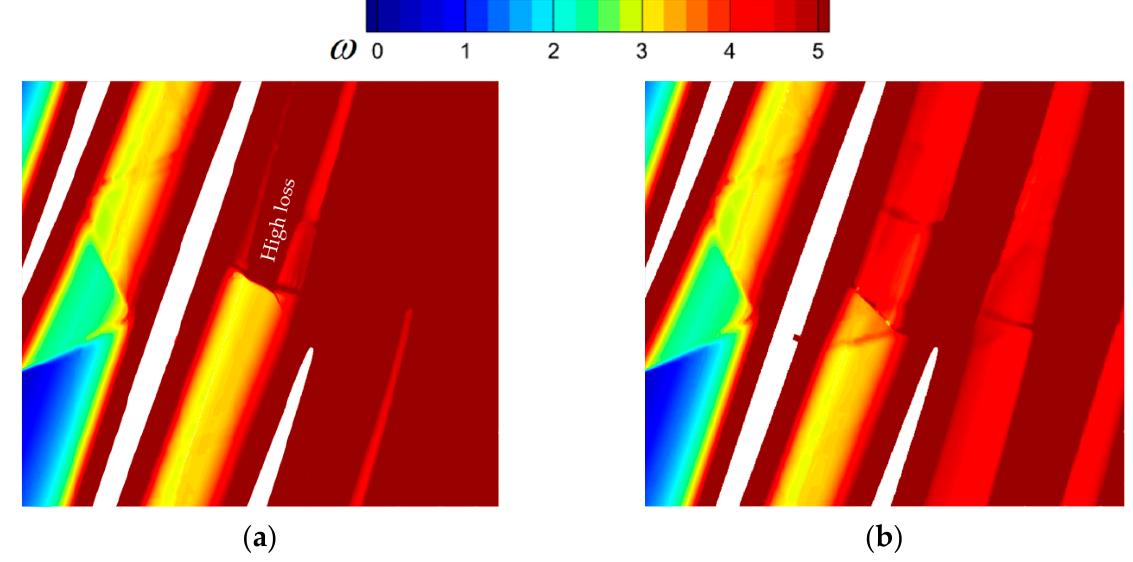
Figure 6. Total pressure loss contours for baseline and controlled cases: ( a ) baseline case; ( b ) controlled case.